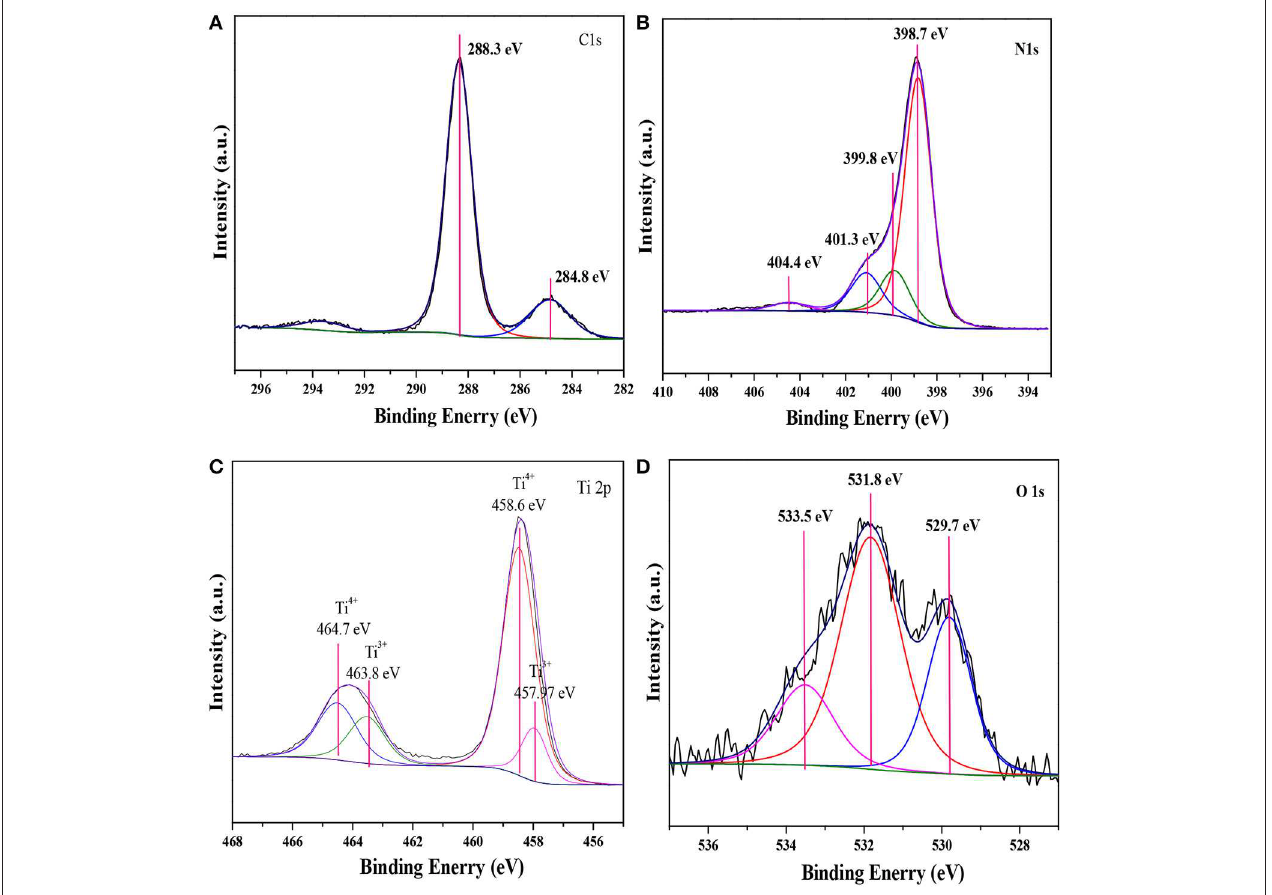
FIGURE 2 | XPS spectra of the 160-Ti 4 O 7 /g-C 3 N 4 photocatalyst. (A) C 1s; (B) N 1s; (C) Ti 2 p; (D) O